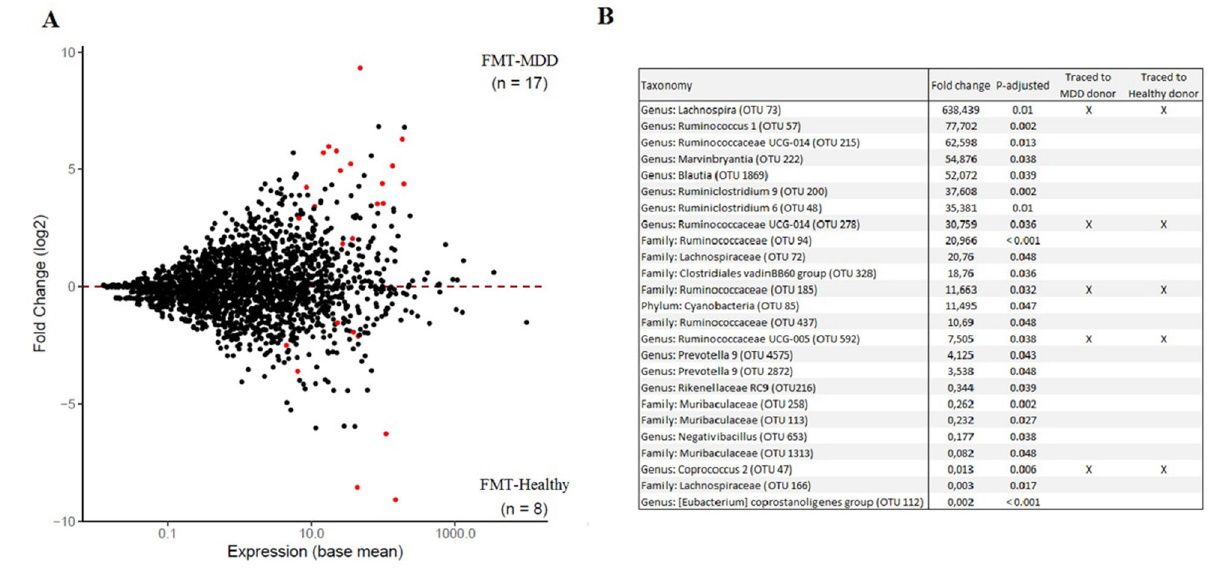
Figure 3. MA plot presenting the fold change in OTU expression between pre-FMT and post-FMT samples collected from FRL rats. ( A ) OTU expression in rats receiving faecal microbiota transplantation (FMT) from patients with MDD (FMT-MDD) compared to rats receiving from healthy individuals (FMT-Healthy). Of all the OTUs, seventeen were elevated in FMT-MDD samples, while eight were depleted compared to FMT-Healthy samples. ( B ) The twenty-five OTUs significantly different between FMT-MDD animals and FMT-Healthy animals. Five of these OTUs, marked by “X”, could be traced to the human donor material. The fold change is expressed as the change in relative abundance of bacteria in the FMT-MDD group compared to the FMT- Healthy group.